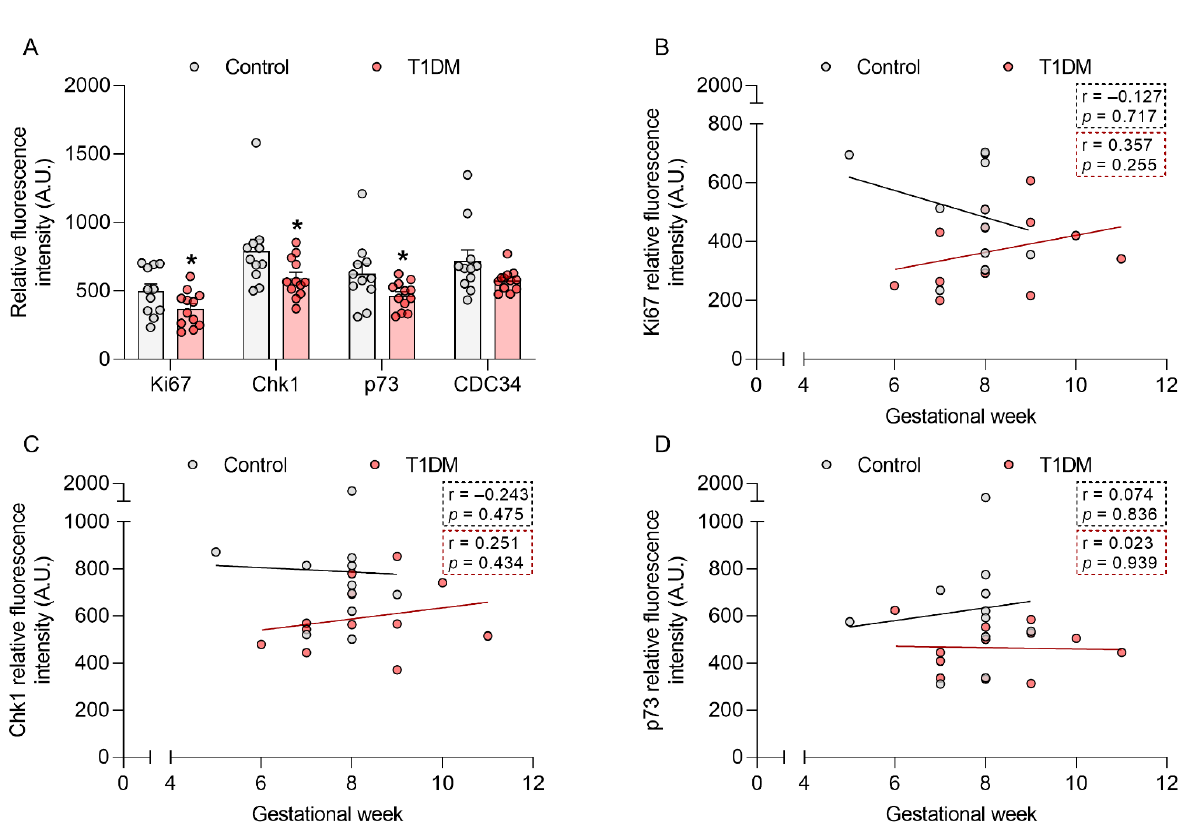
Figure 3. Hyperglycemia decreases viable cell count in human first trimester trophoblasts and does not affect cell death or cell distribution within the cell cycle. Primary human first trimester trophoblasts (gestational week (GW) 7–8, n = 8; GW 9–10, n = 4; GW 11–12, n = 2) were cultured in absence (control) or presence of 25 mM D-glucose (hyperglycemia) and 5.5 mM D-glucose + 19.5 mM D-mannitol (osmotic control) for 48 h. The numbers of viable ( A ) and dead cells ( B ) were counted in duplicates using the CASY TTC Cell Analyzer. The proportion of cells in the different phases of the cell cycle was determined by FACS ( C ). The ratio between the number of cells in G 2 /M and G 0 /G 1 was also calculated ( D ). Results were calculated relative to the control, arbitrarily set to 1, and presented as mean ± SEM ( A , B , D ) or expressed as percentage of cells ( C ). Statistical analysis used Wilcoxon signed rank test. * p < 0.05 vs. control.